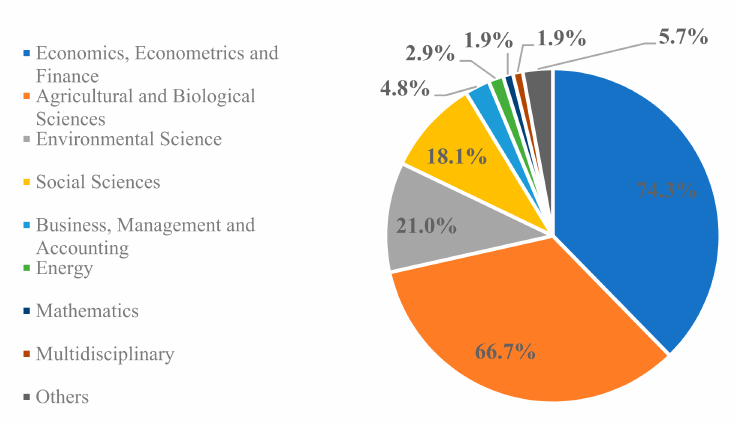
Figure 3. Distribution of EEA research by subject